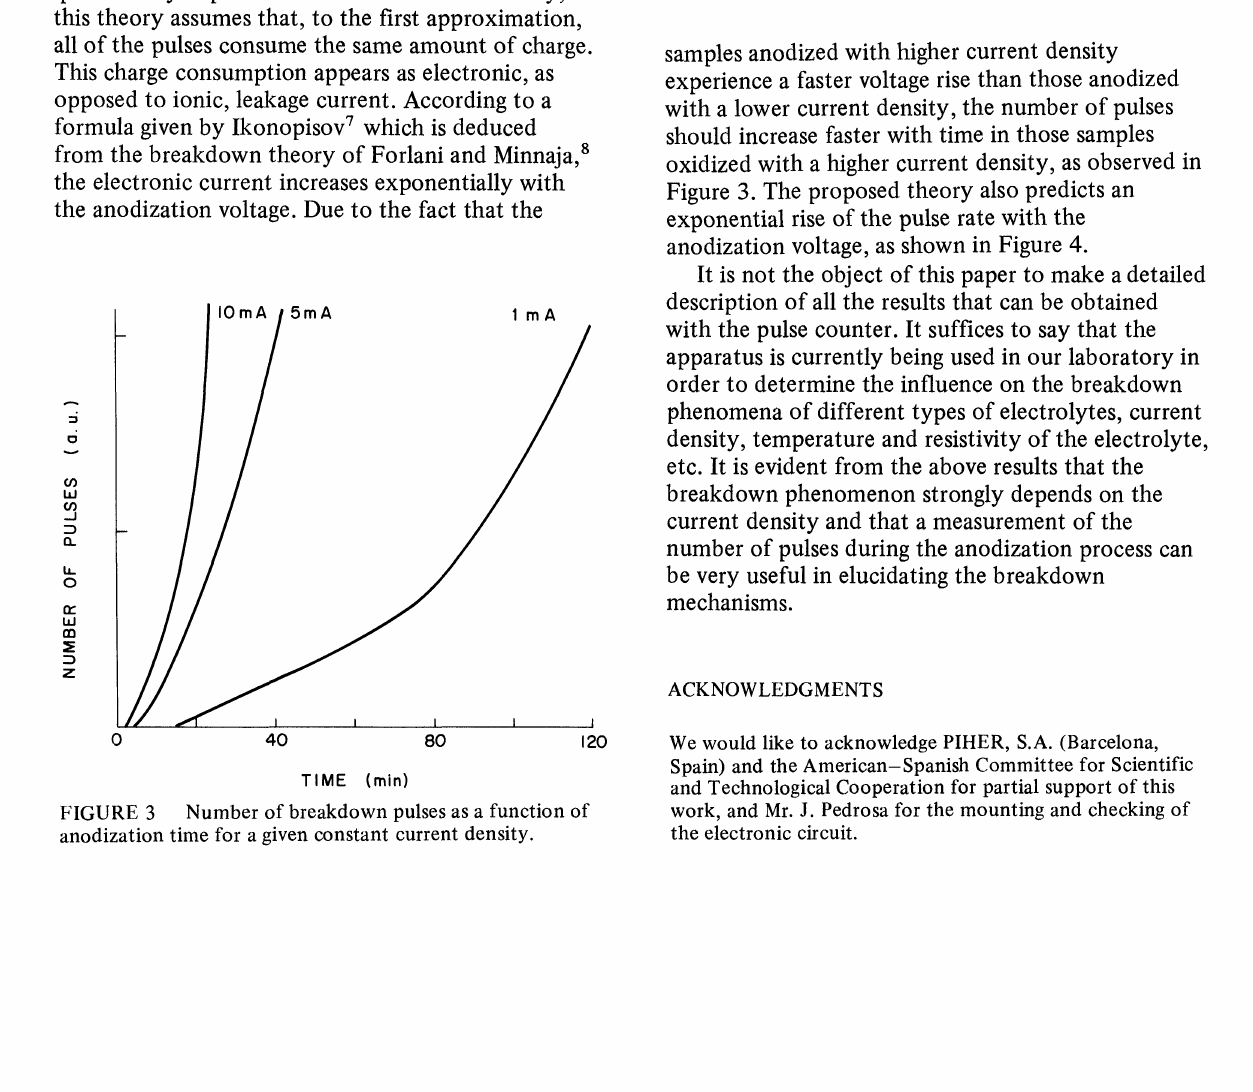
Number of pulses per unit time as a function of the anodization voltage for a given constant current